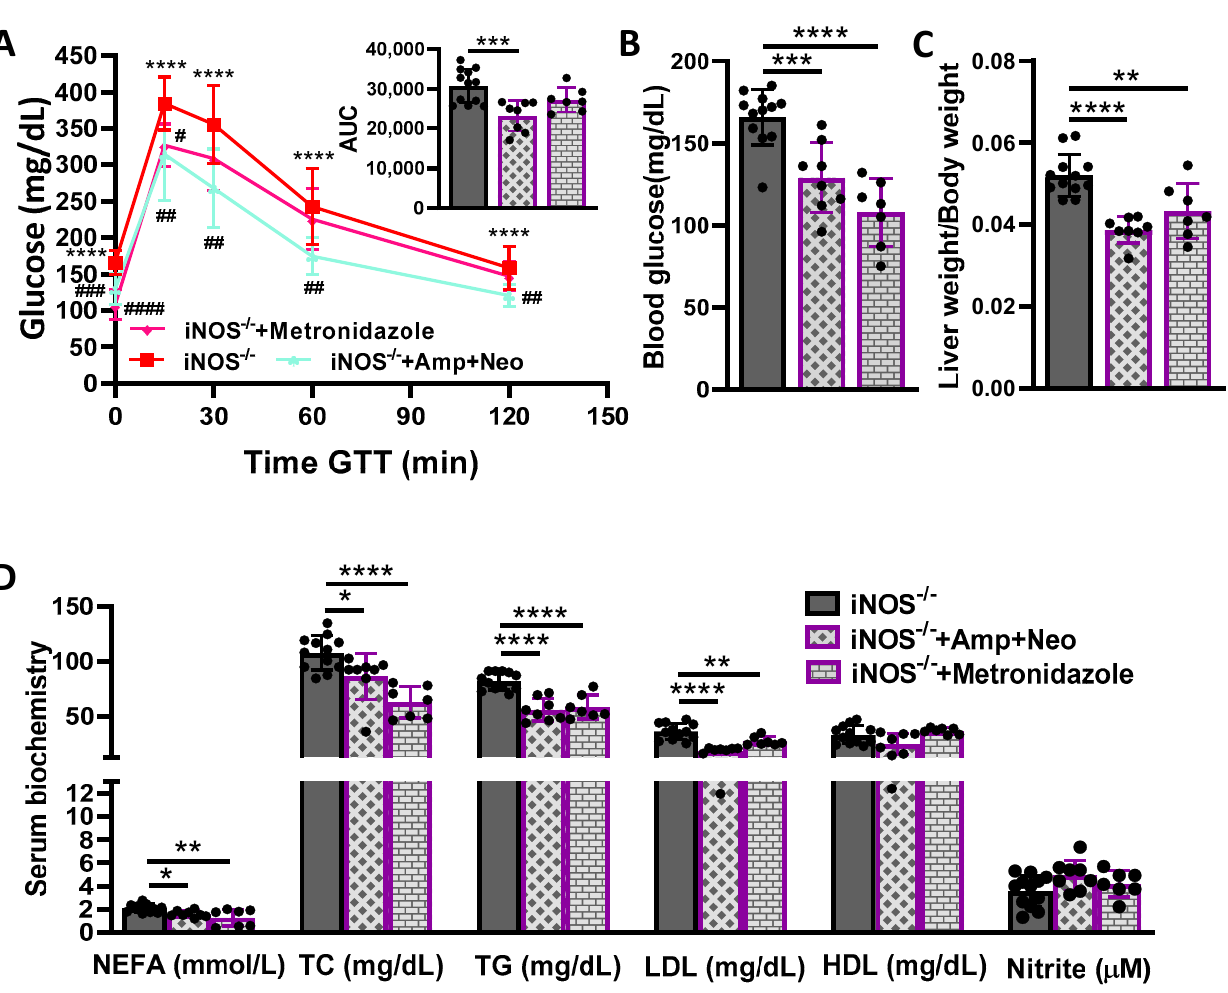
Figure 3. Effect of antibiotics on systemic glucose homeostasis and dyslipidemia in iNOS -/- mice. Systemic glucose and lipid homeostasis in iNOS -/- mice upon treatment with ampicillin-neomycin combination and metronidazole. ( A ) Intraperitoneal glucose tolerance test (GTT) with AUC calculated from IPGTT data, ( B ) Fasting blood glucose levels, ( C ) Relative liver-body weight ratio and ( D ) Serum lipids and total nitrite levels. Data are represented as mean ± SD ( n = 7–12). * p < 0.05, ** p < 0.01, *** p < 0.001 and **** p < 0.0001 between indicated groups. # p < 0.05, ## p < 0.01, ### p < 0.001 and #### p < 0.0001 vs. iNOS -/- in GTT curve.